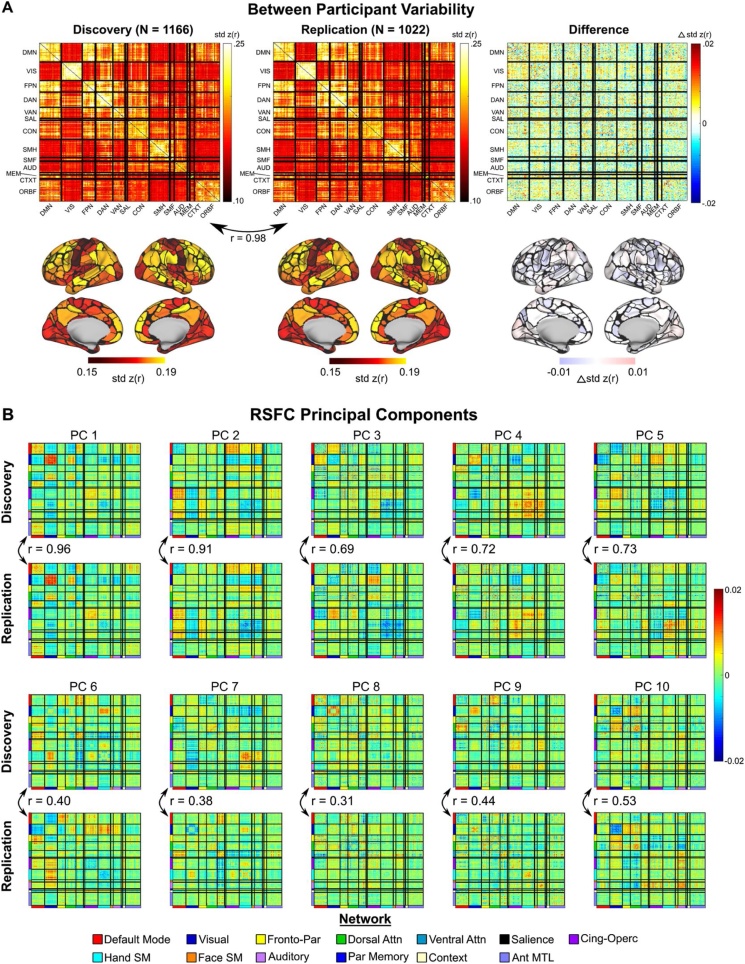
Between-participant variance in RSFC. (A)Top row: Between-participants variability (standard deviation across participants) in RSFC for each ROI pair. Colorbar represents the magnitude of between-participants variability. Bottom row: Regional between-participants variability in RSFC, obtained by averaging the standard deviation of RSFC across all ROI pairs for each ROI. Similar to adults, children exhibit the greatest relative degree of between-participants variability within control and attention networks. (B) First 10 principal components of RSFC across participants in the discovery and replication datasets, accounting for 11.88% and 11.73% of the total variance across participants, respectively. Similar to prior work in adult samples (Smith et al., 2015), reproducible motifs of between participant variance are observed outside of traditional network architecture.